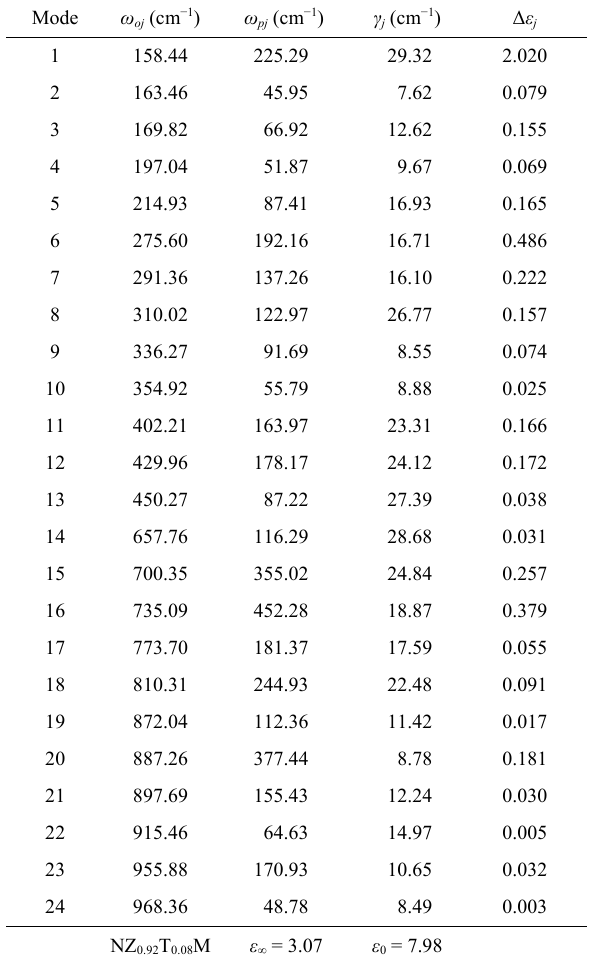
Table 3 Results obtained from the fitting of IR reflectivity spectrum of NZ 0.92 T 0.08